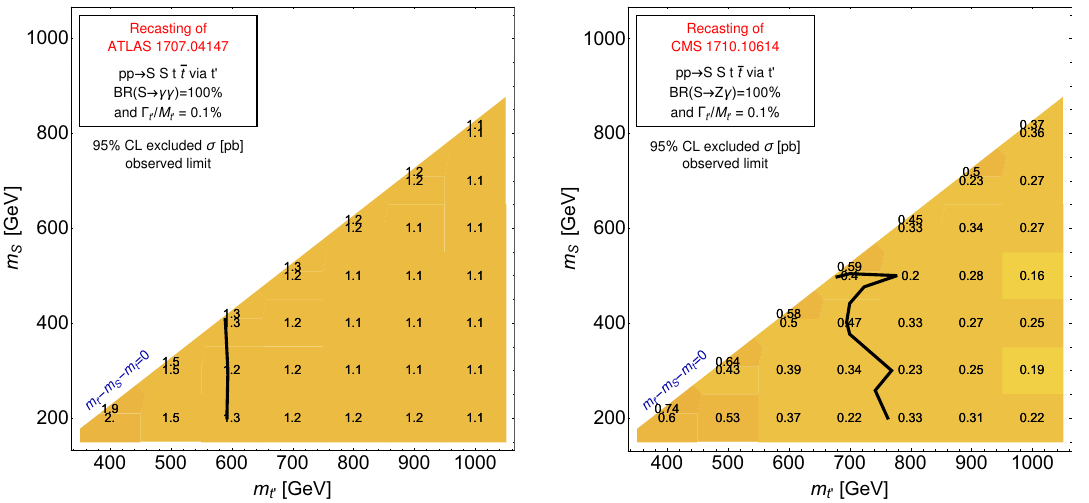
Figure 2 . Upper limits on the cross section in the m t 0 vs m S plane for the (cid:13) (cid:13) (left panel) and Z (cid:13) channels (right panel) from the recast of the ATLAS search [42] and CMS search [43], respectively. The solid black lines represents the bounds on the two masses obtained by comparing the upper limits with the pair production cross section of t 0 at NLO+NNLL computed through Hathor [52] under the assumption of 100% BRs for both t 0 and S in the respective channels and in the narrow width approximation